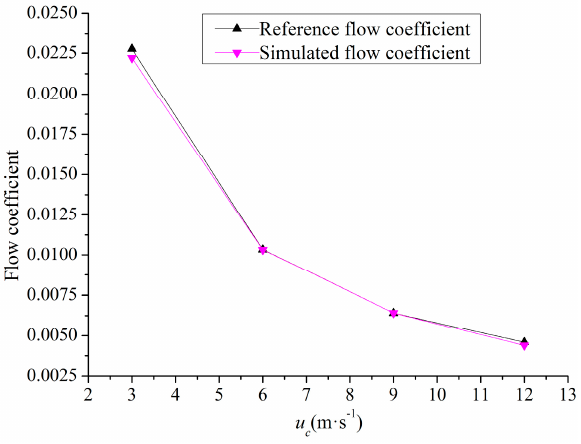
Figure 7. Dimensionless flow coe ffi cient of the DACC as a whole at di ff erent